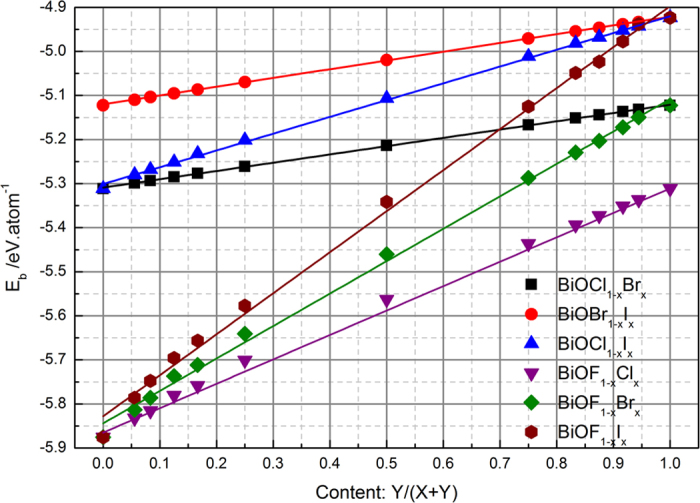
Binding energy of BiOX1−xYx solid solutions as a function of content x.